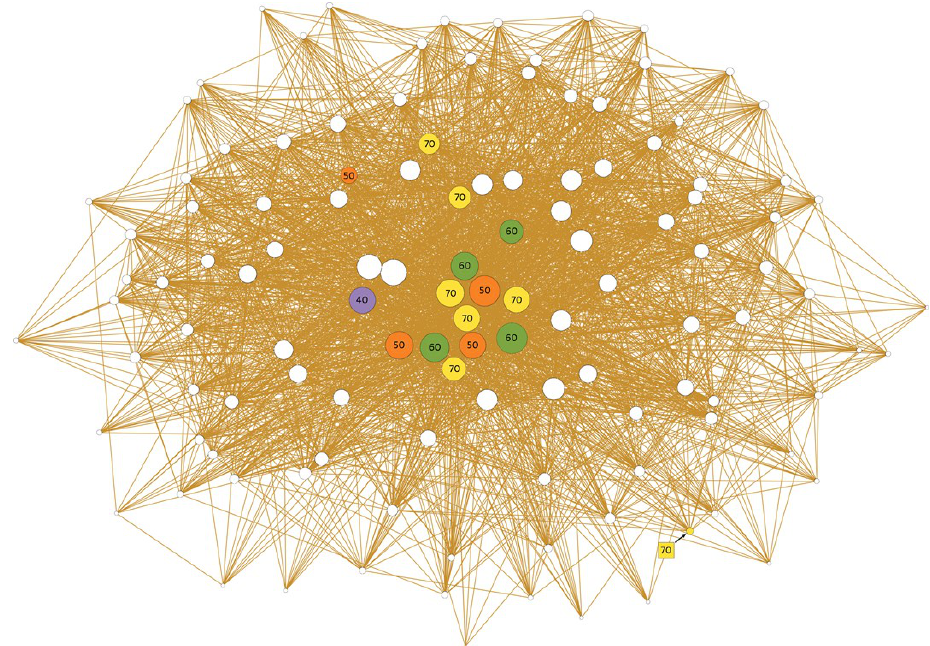
Figure 1. Social network graph detailing social recognition of magical expertise